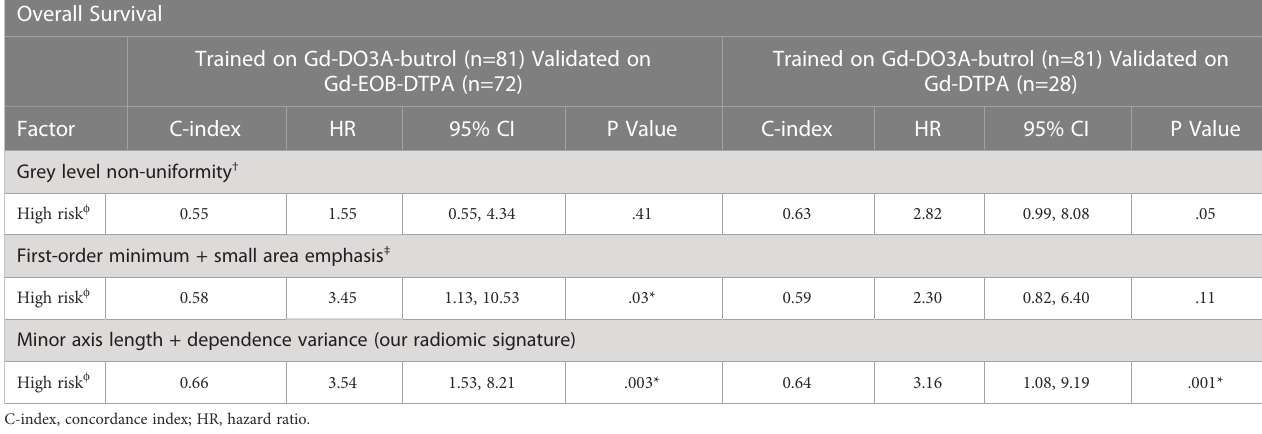
TABLE 5 Comparison of generalizability of biomarkers when applied to different contrast agents. Overall Survival Trained on Gd-DO3A-butrol (n=81) Validated